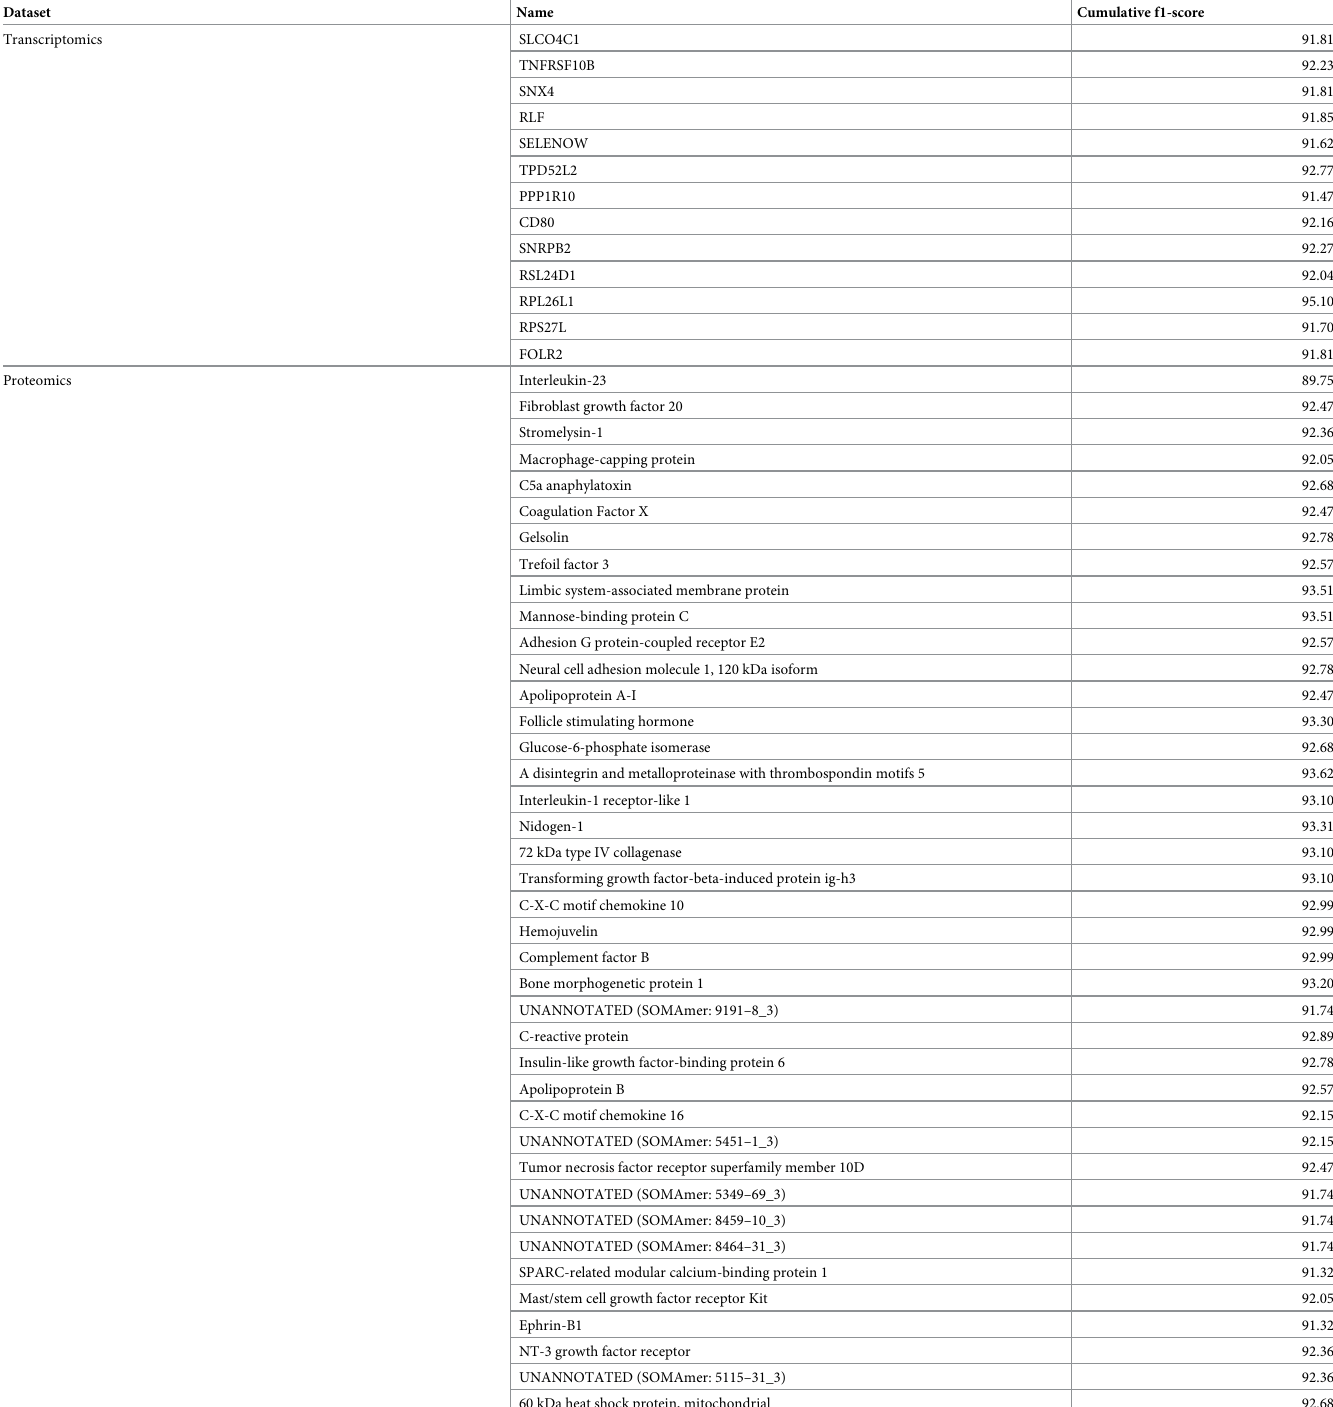
Table 4. Features selected by SVMRFE for each omic type after 5-fold cross-validation. Cumulative score is the classification metric (f1-score) of an SVM used to pre- dict the cluster labels using only the features at and above that feature (e.g., score for Fibroblast growth factor 20 is the result of an SVM trained on feature set [Interleukin- 23, Fibroblast growth factor 20]). These scores are not used to select the size of the feature sets because the size is selected before features are ranked (see